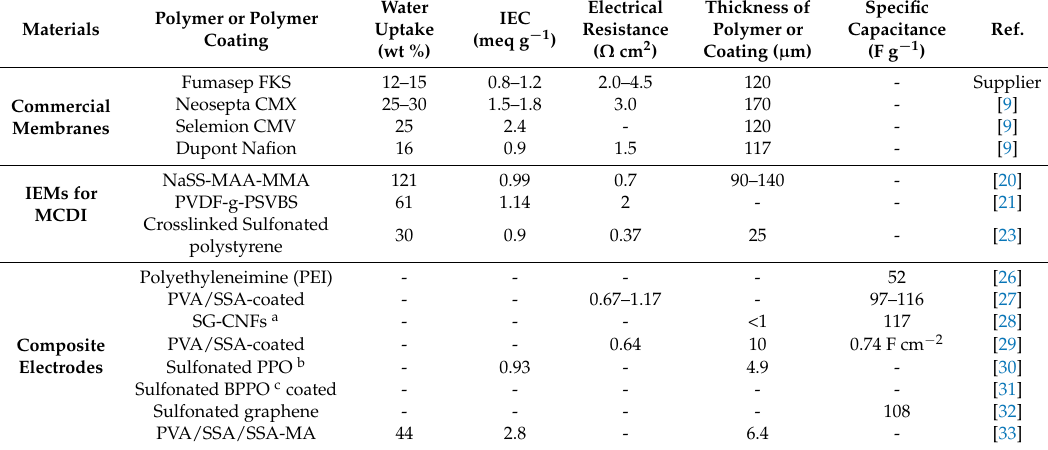
Table 1. Fabrication and characterization properties of different cation-exchange membranes (CEMs) and composite electrodes for use in membrane capacitive deionisation (MCDI) processes.